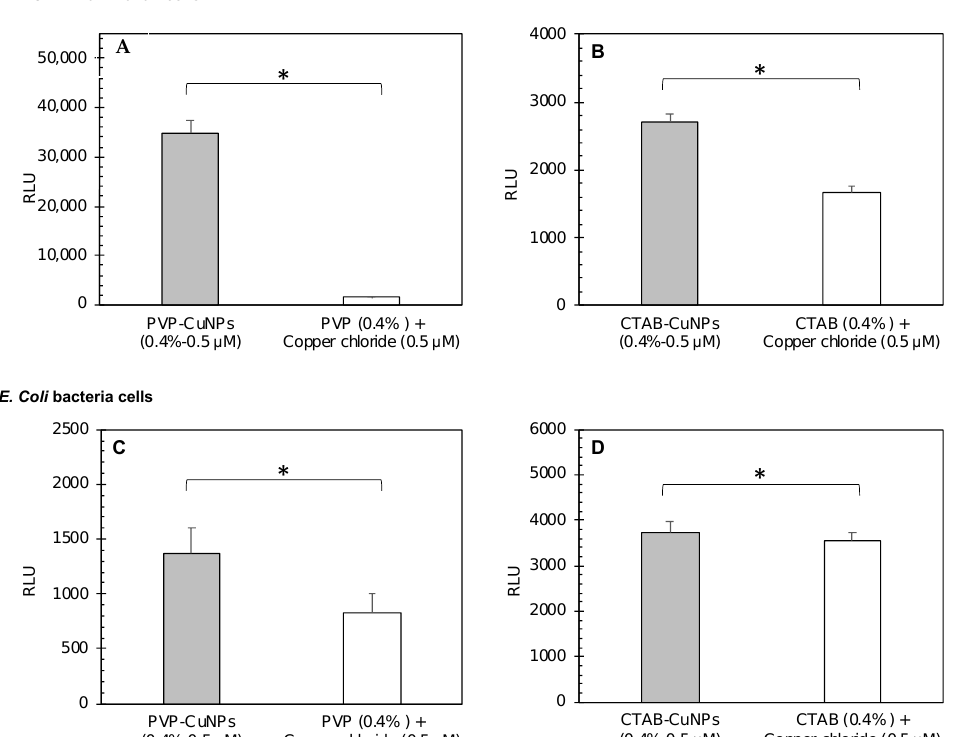
Figure 6. Calculated (effects of stabilizing agents plus effects of copper chloride) versus measured (surface-stabilized copper nanoparticle) relative luminescence units (RLU). The different copper nanoparticles (0.5 and 1.0 µ M PVP-CuNPs and 0.5 and 1.0 µ M CTAB-CuNPs) against ( A , B ) BEAS-2B mammalian cells and ( C , D ) E. coli bacterial cells. In each panel, the measured RLU is presented as the average of triplicate measurements, and the error bar shows the standard deviation; the asterisk indicates that the measured RLU was significantly lower than the calculated RFU ( p < 0.05), indicating a consistent synergistic effect for PVP-CuNPs in both mammalian and bacterial cells (except for 0.5 nM PVP-CuNPs, where the results are equivalent) and contradicting effects for CTAB-CuNPs in mammalian cells (antagonistic effect) versus bacterial cells (synergistic effect). Black asterisks indicate that the surface-stabilized copper nanoparticle is significantly higher in RLUs than the 0.4% stabilizing agent plus 50 µM copper chloride co-exposure. Red asterisks indicate that the surface-stabilized copper nanoparticle is significantly lower in RLUs than the 0.4% stabilizing agent plus 50 µM copper chloride co-exposure.